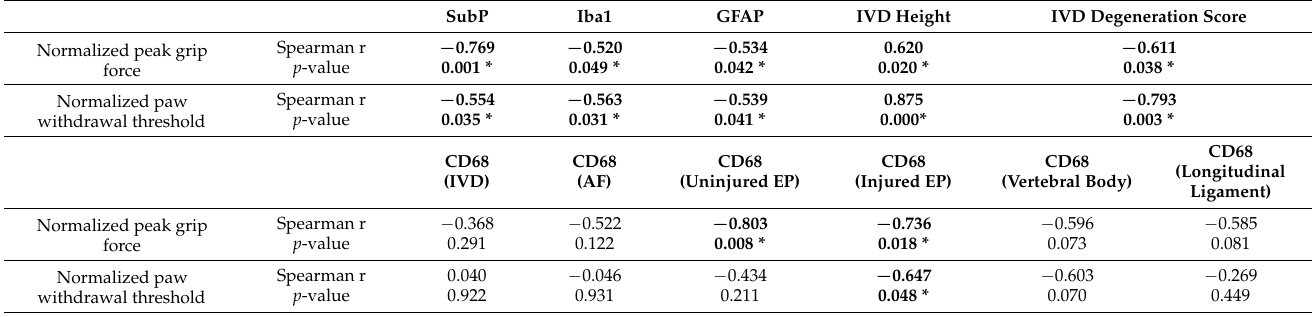
Table 2. Correlation analysis to identify important factors contributing to pain-related behaviors.